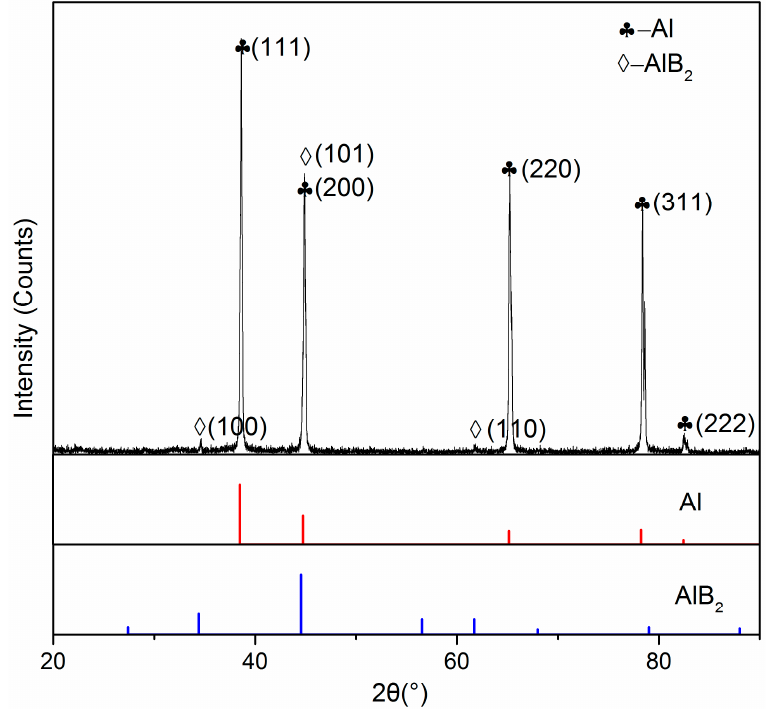
Figure 1. XRD results for the Al-3B mater Figure 1 . XRD results for the Al-3B mater alloy.